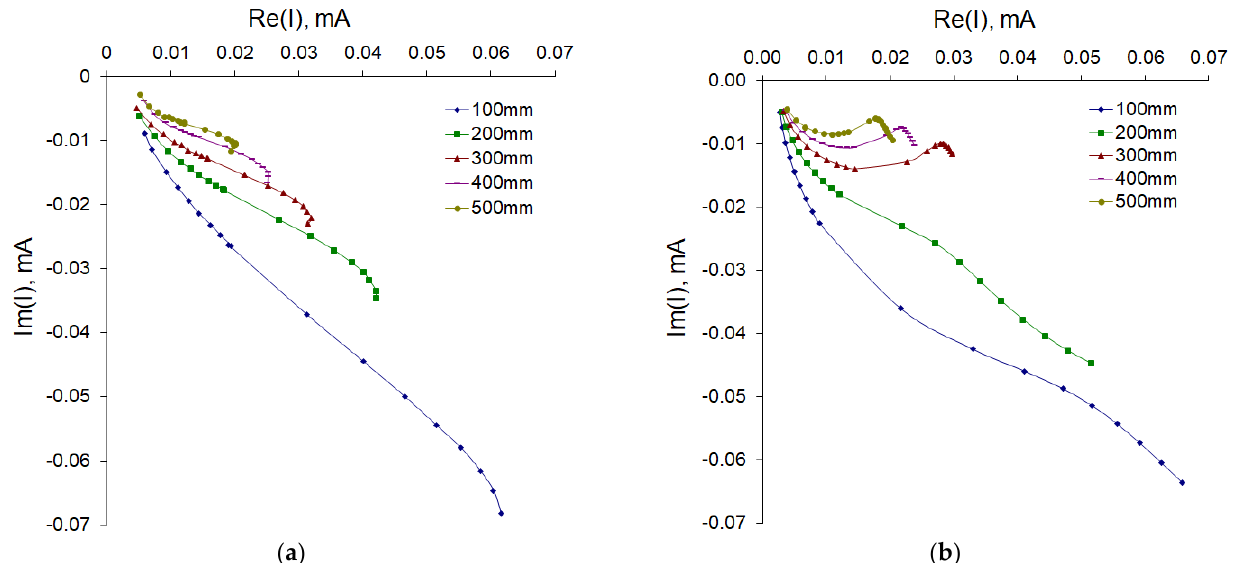
Figure 4. Nyquist plots for apple samples with different lengths. Experimental data ( a ) and model fitting ( b ). All samples were 23 mm in diameter. The number of samples in each experimental group is 5 and the number of measurement repetitions is 5. Data are presented as mean values.